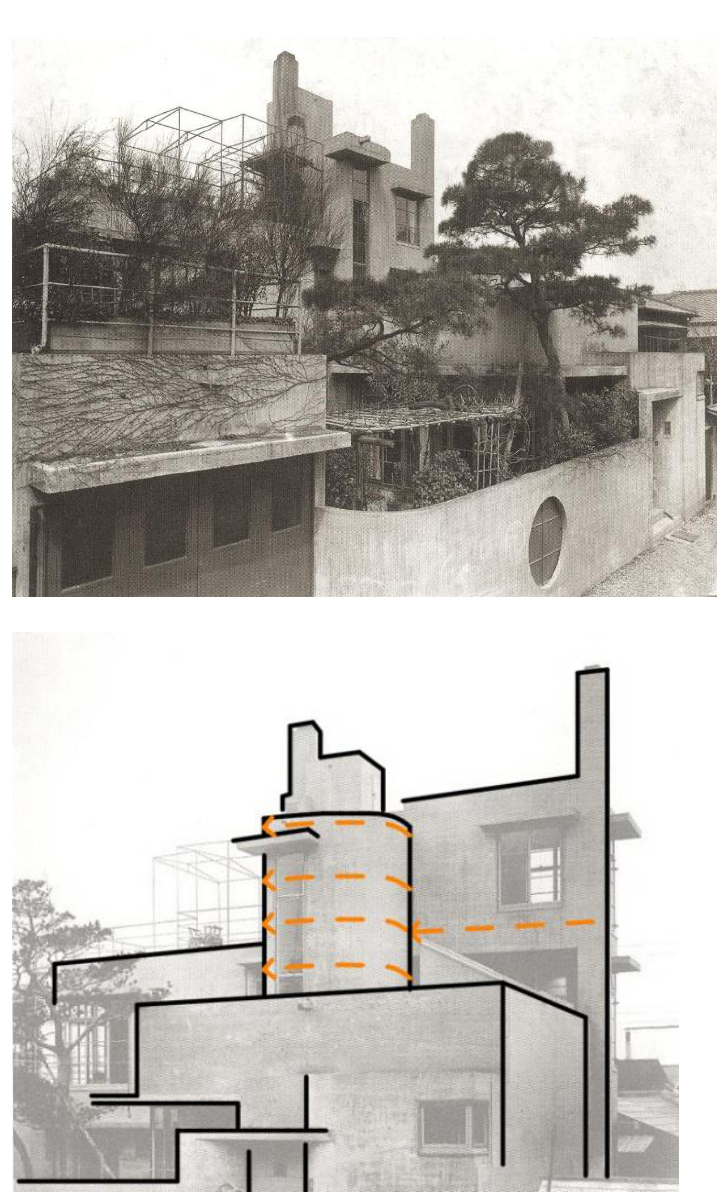
Figure 5. Reinanzaka house of the Raymond family (1924) and its concrete plasticity. Built completely out of reinforced concrete, Reinanzaka House constituted a huge step forward and a liberation from Frank Lloyd Wright’s mannerism, predating modern architecture. Like everything Raymond designed after the Kanto Earthquake of 1923, the house had an earthquake proof structure of reinforced concrete. The exposed concrete was not clad with cement mortar or any other finishes, which emphasized Raymond’s belief that there is inherent beauty in concrete and that it has its own character if studied and understood [16]. He created a monolithic enclosure surrounding the house and garden. The configuration was striking because it was dissimilar to his former designs and also to local productions. For the organization and separation of the functions (the living areas from the servant’s areas), he articulated three aisles under a U-shaped plan (Figure